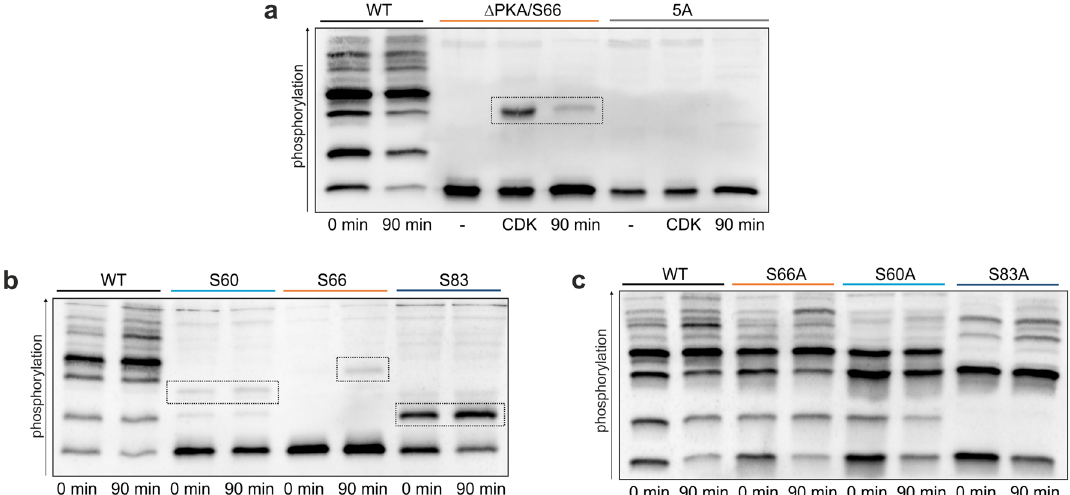
Figure 3. The Nth1-reporter construct is phosphorylated by PKA and Cdk1 in vivo. ( a ) Phos-tag-SDS-PAGE of 3xFLAG-tagged Nth1-reporter constructs. Cells were grown on 1% EMM and arrested in G 1 . The cell lysate of arrested cells was phosphorylated in vitro with recombinant human CyclinB-Cdk1 or incubated with ATP only (−) and compared to lysates of cells that were synchronously released into the cell cycle. ( b ) and ( c ) Phos-tag Western Blots of cells expressing 3x-FLAG-tagged Nth1-reporter constructs grown on 1% EMM and synchronously released into the cell